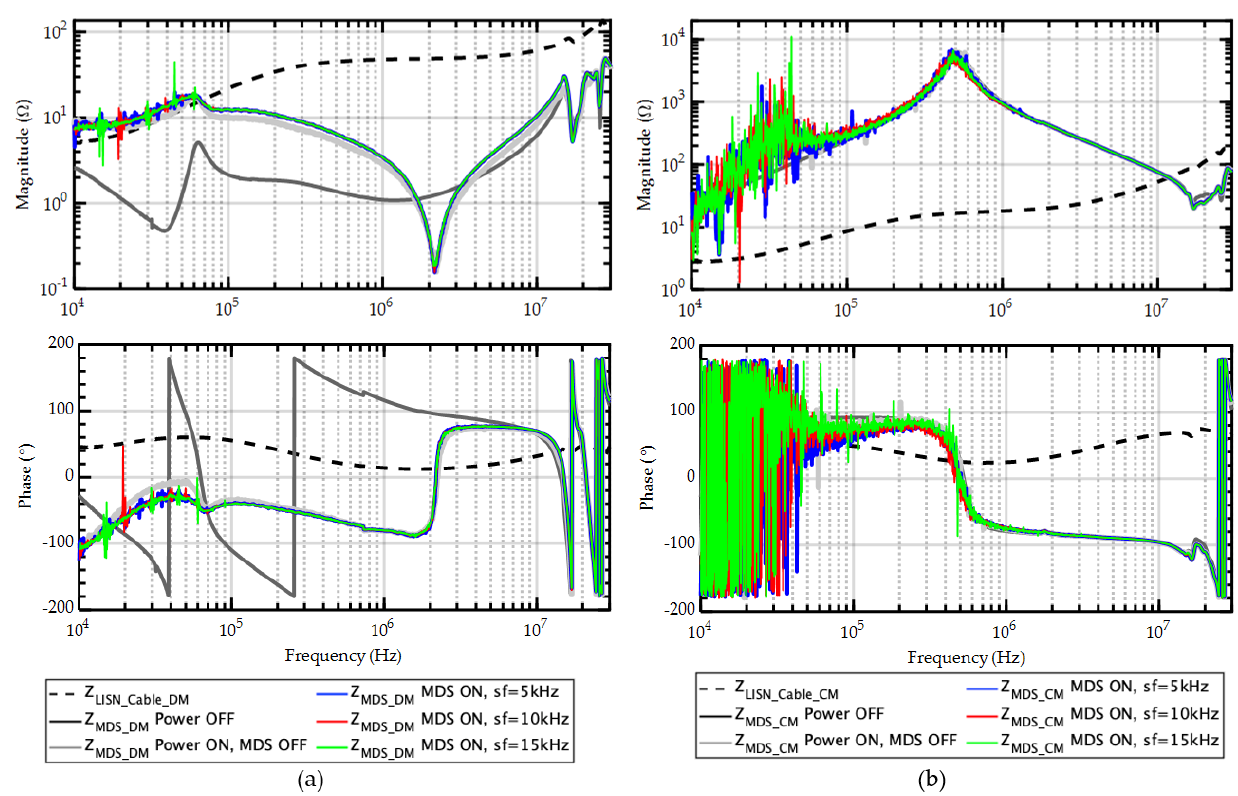
Figure 10. Impedances in the motor drive system equivalent modal circuits: ( a ) DM and ( b ) CM. The impedances of the LISN and cable in the equivalent modal circuits (see black dash line in Figure 10: Z LISN_Cable_DM and Z LISN_Cable_CM ) are almost equal to 50 Ω and 50/3 Ω in